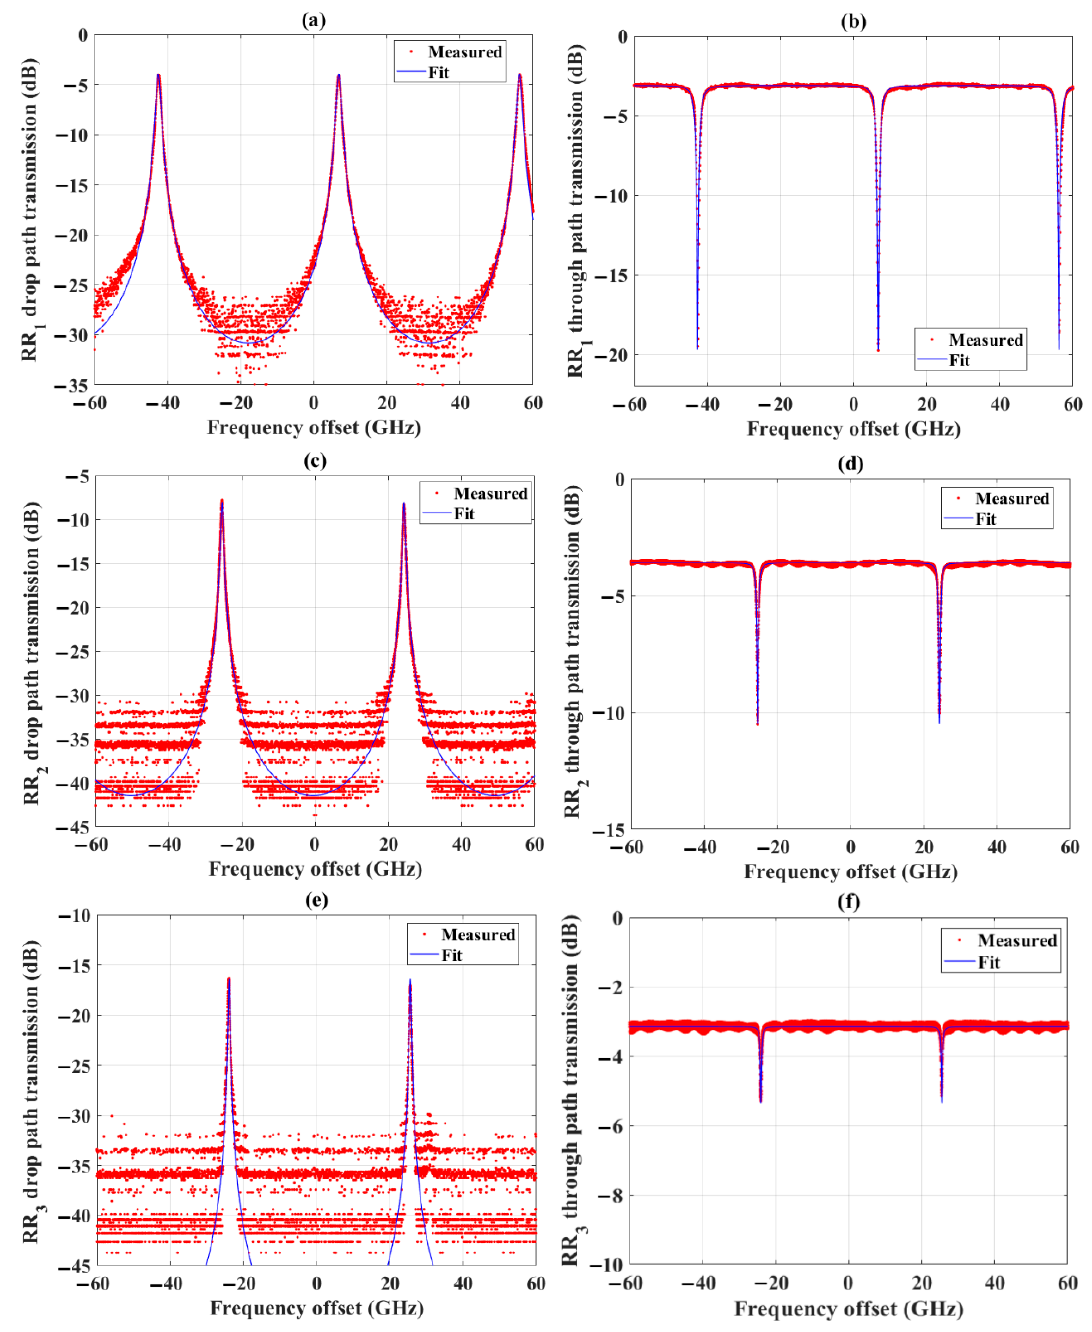
Figure 6. Drop- and through-path transmission spectra for ( a , b ) RR 1 , ( c , d ) RR 2 , and ( e , f ) RR 3 . The measurements have been taken with 0.1 pm resolution using the abovementioned experimental setup. The reference frequency is 193.414 THz (1550 nm). Table 1. Measured and extracted parameters of fabricated ring resonators.